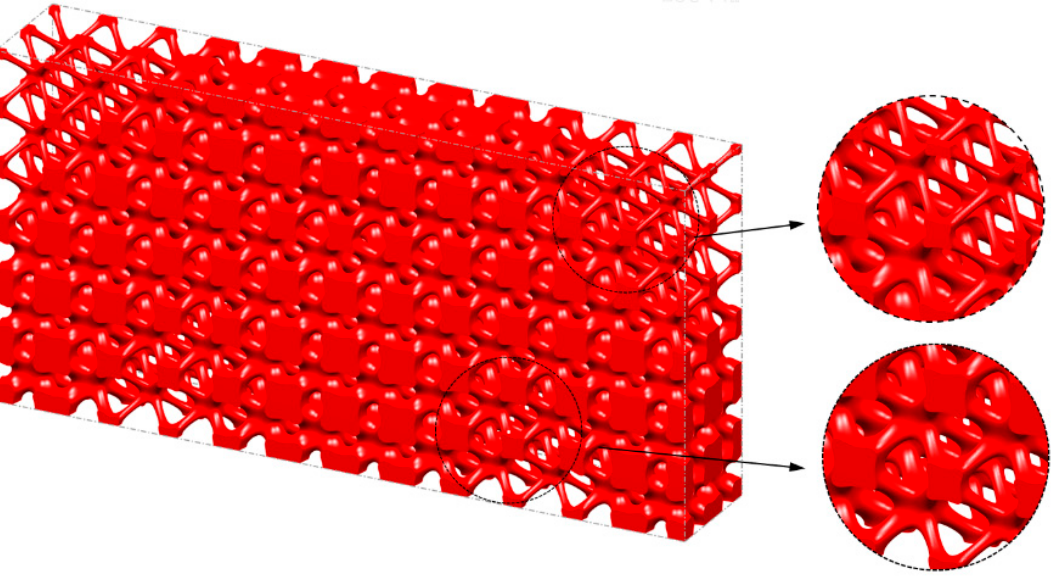
Figure 14. Optimized 3D Michell beam using the HLSM.